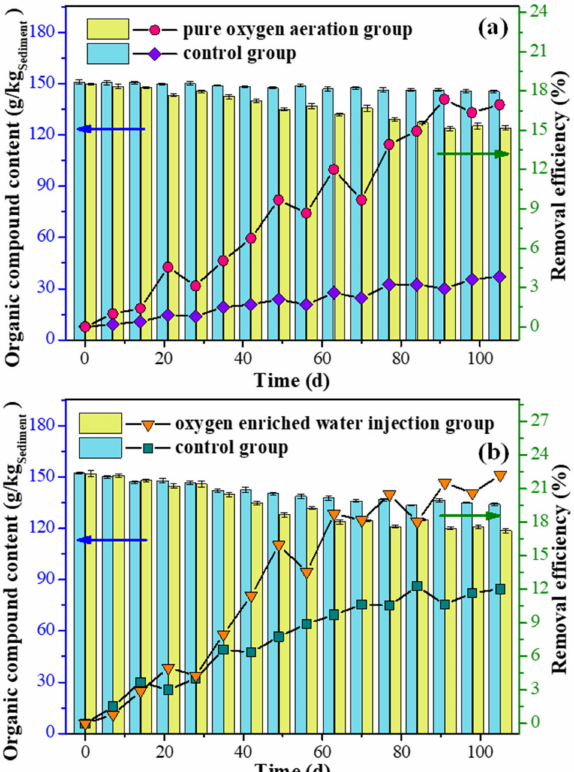
Figure 5. ( a ) The e ff ects of the pure oxygen aeration treatment on the organic compound content in the sediment, and ( b ) the e ff ects of the oxygen enriched water injection treatment on the organic compound content in the